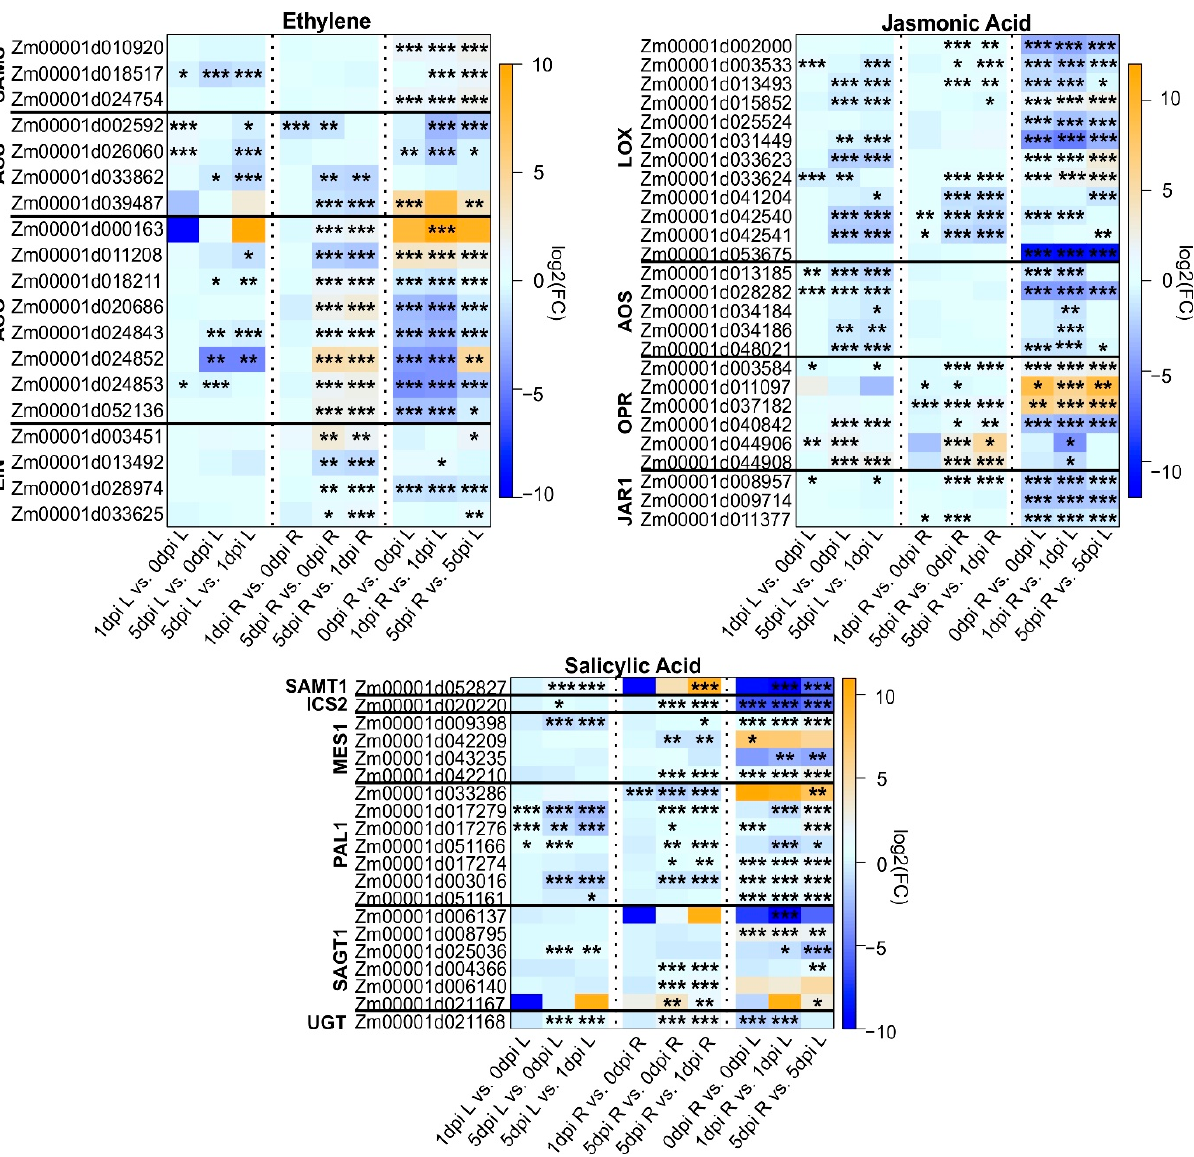
Figure 5. Heatmap of genes encoding plant hormonal pathways related to ethylene (ET), jasmonic acid (JA), and salicylic acid (SA). Each column corresponds to a condition for each tissue (L: leaves or R: roots). Each cell contains the corresponding log 2 (fold-change (FC Infested/Uninfested); genes upregulated are indicated in orange and downregulated in blue) and adjusted p value (*** < 0.001, 0.001 < ** < 0.01, 0.01 < * < 0.05).